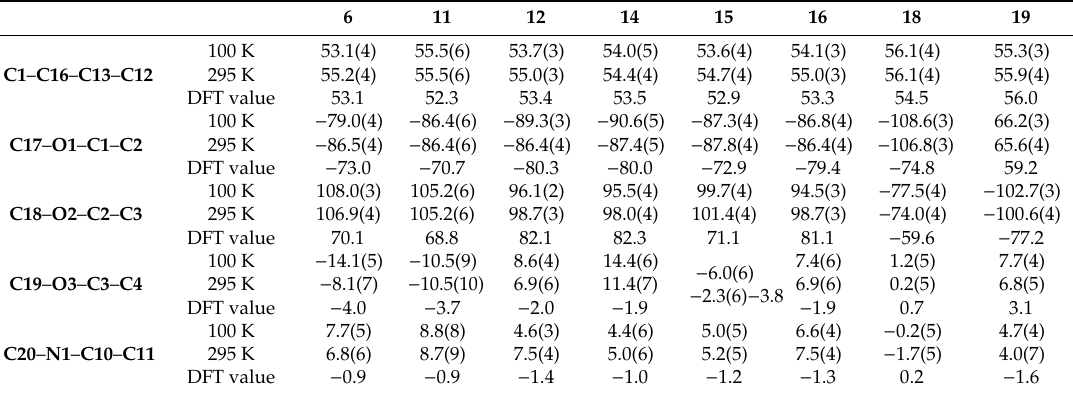
Table 1. Selected torsion angles ( ◦ ) of colchicine derivatives 6 , 11 , 12 , 14 , 15 , 16 , 18 and 19 obtained by X-ray analysis and DFT computation for a